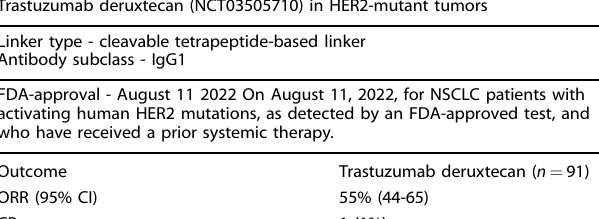
Table 2. Summary of current key antibody-drug conjugate (ADC) clinical data in metastatic